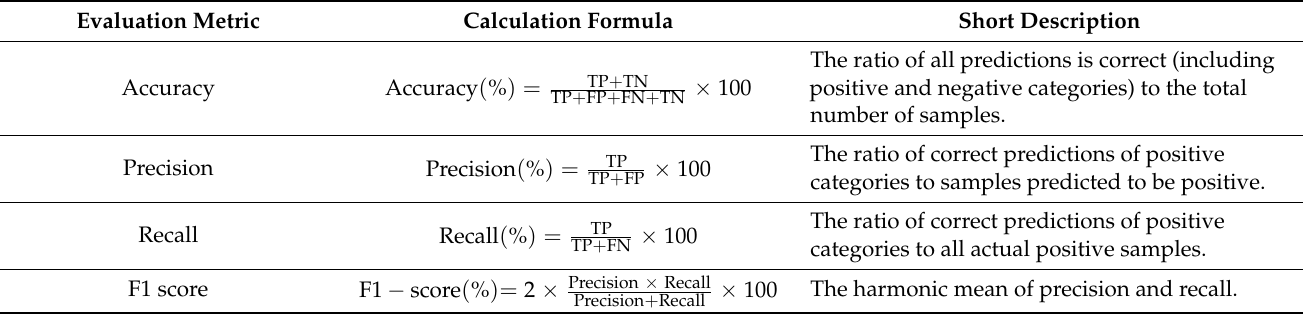
Table 2. Evaluation metrics.